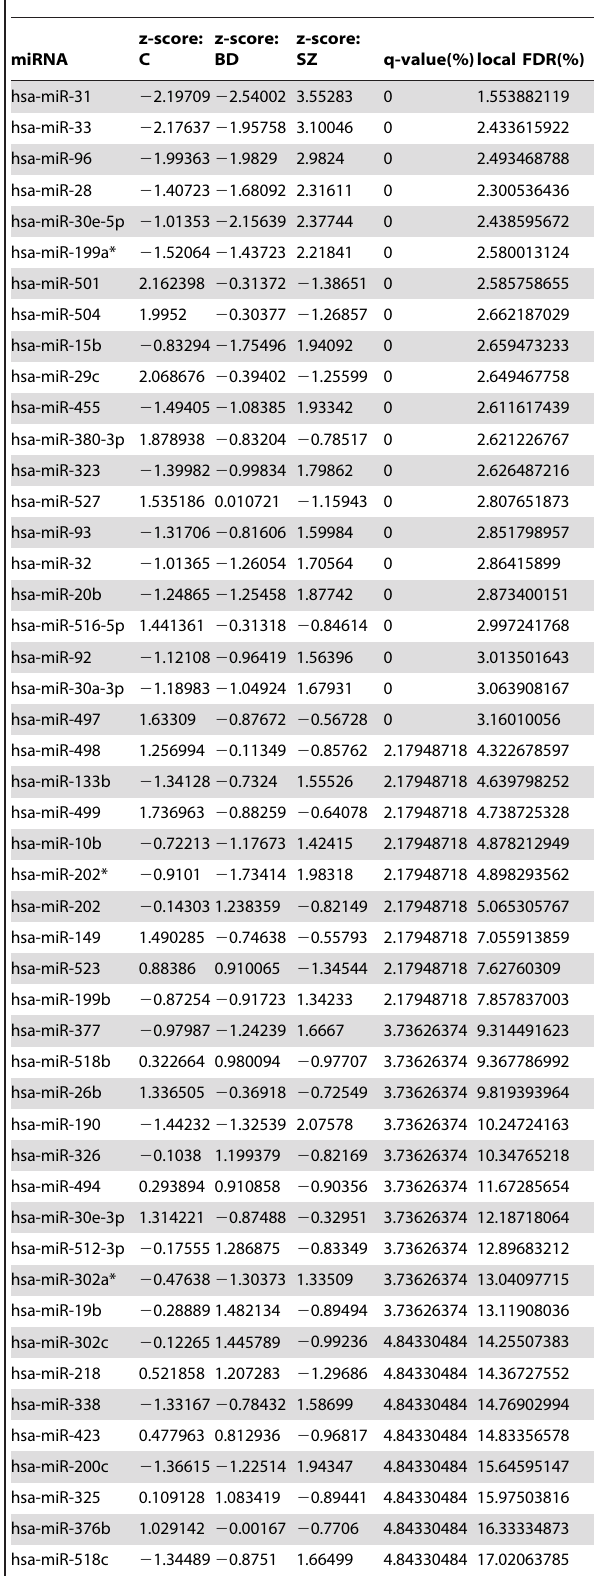
Table 2. SAM test of Luminex miRNA expression data for all 3 examined groups of cases: SZ, BD, and